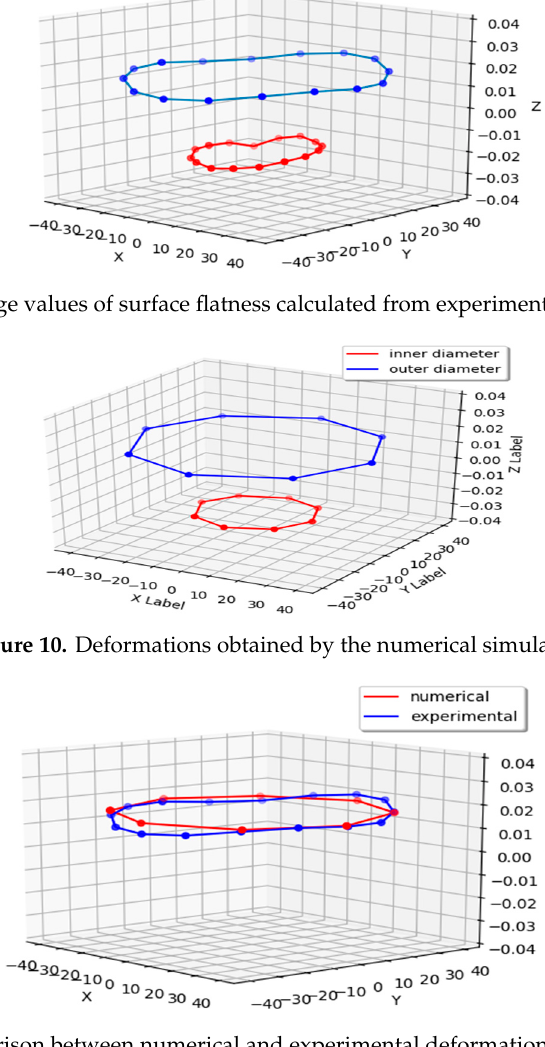
Figure 11. Comparison between numerical and experimental deformations on the outer circle. Figure 10. Deformations obtained by the numerical simulation.